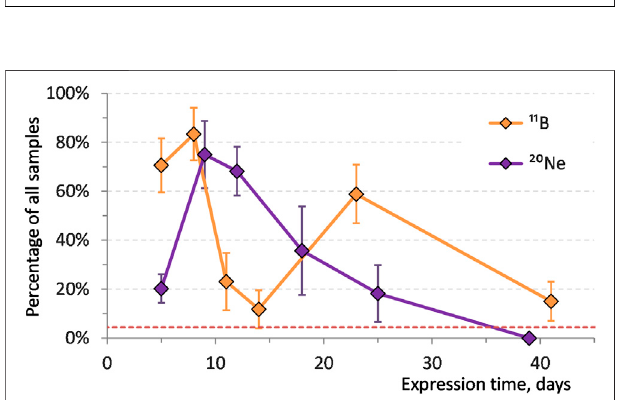
FIGURE 6 | Distributions of the characteristic exons missing in HPRT mutants on expression time after irradiation by 2 Gy of 11 B ions — exon 9 deletions and 20 Ne ions — exons 1 and 2 deletions. Red dashed line represents partial deletions level of spontaneous mutants. Error bars represent standard error of the mean.